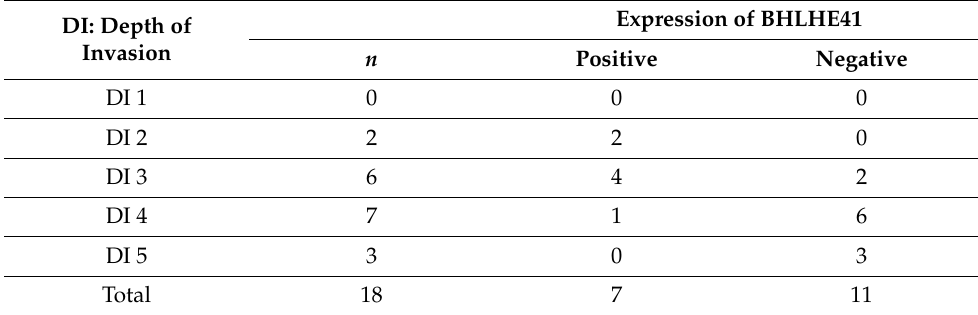
Table 4. Correlation of BHLHE41 expression and DI of early